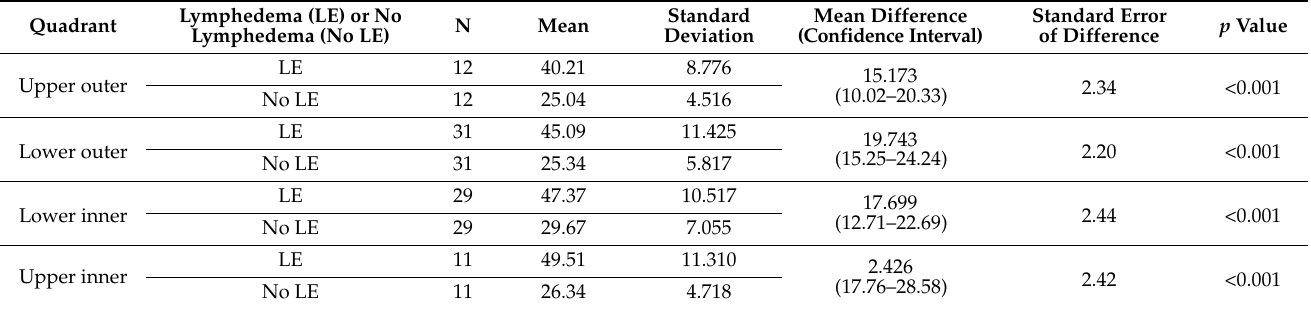
Table 6. Tissue Dielectric Constant of the individual breast quadrants, comparing the edematous to contralateral